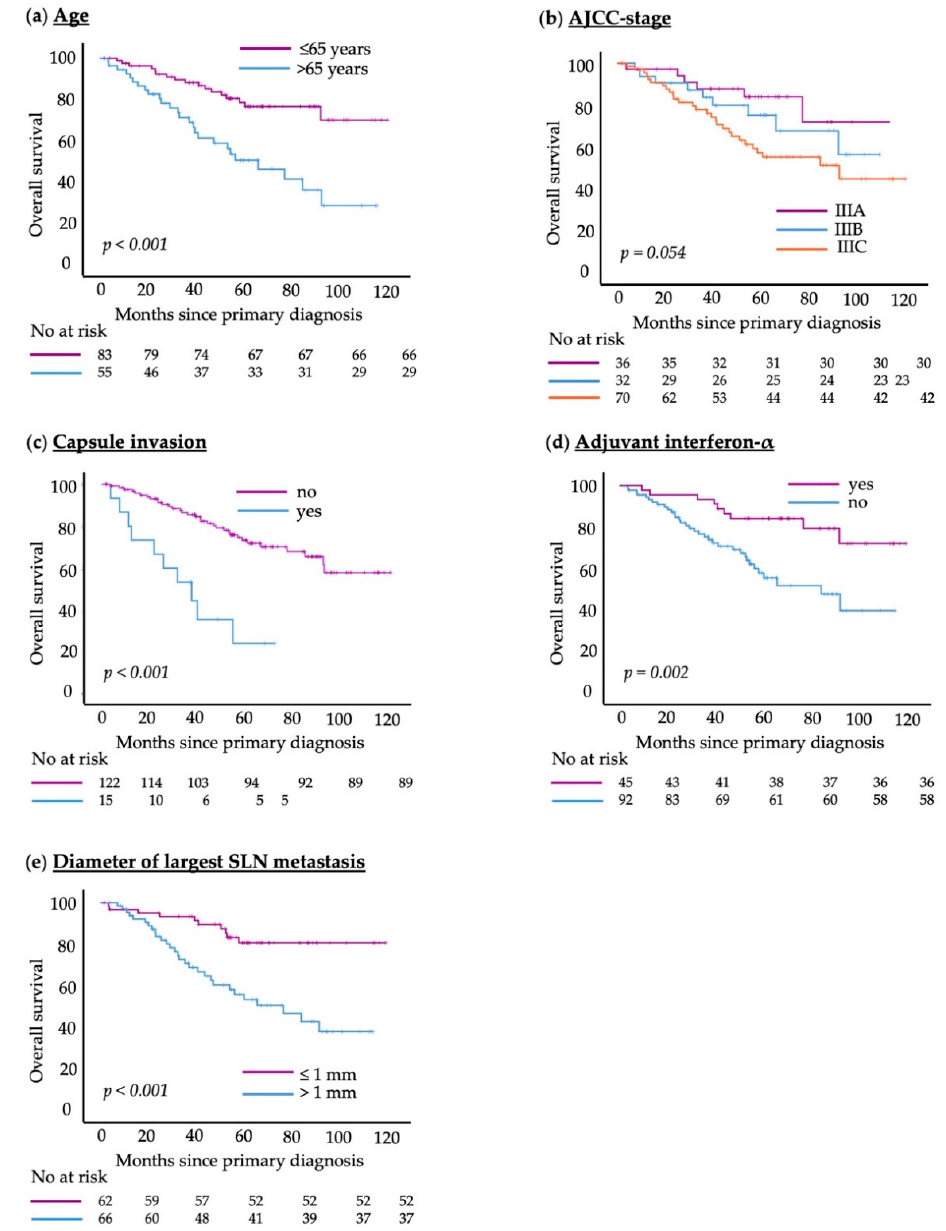
Figure 2. Kaplan–Meier survival curves showing recurrence-free survival for covariates of the multivariate Cox regression model: ( a ) patient age; ( b ) AJCC-stage; ( c ) capsule invasion of SLN metastasis; ( d ) adjuvant interferon- α therapy; ( e ) diameter of largest SLN metastasis. The log-rank test was used to compare between groups; p < 0.05 was considered significant.